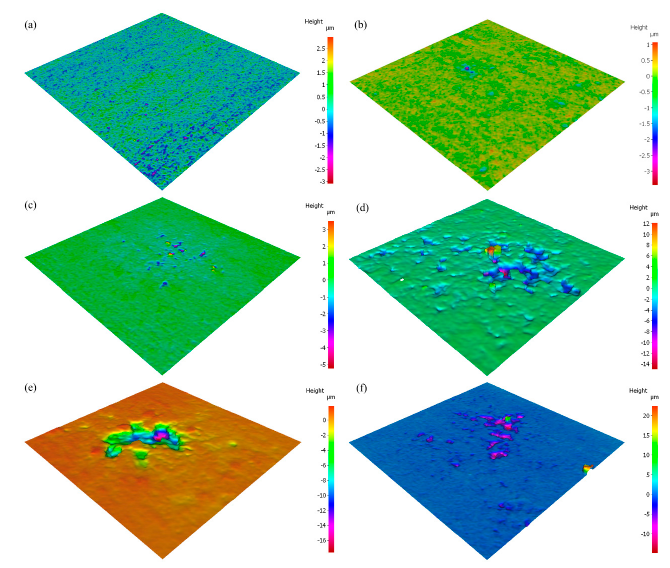
Figure 7. Infinite focus microscope (IFM) 3D images of pitting observed on AA5083 after polarization in 3.5 wt% NaCl solution sensitized at 150 °C for ( a ) 0 days, ( b ) 2 days, ( c ) 7 days, ( d ) 14 days, ( e ) 21 days and ( f ) 30 days. Metals 2020 , 10 , x FOR PEER REVIEW